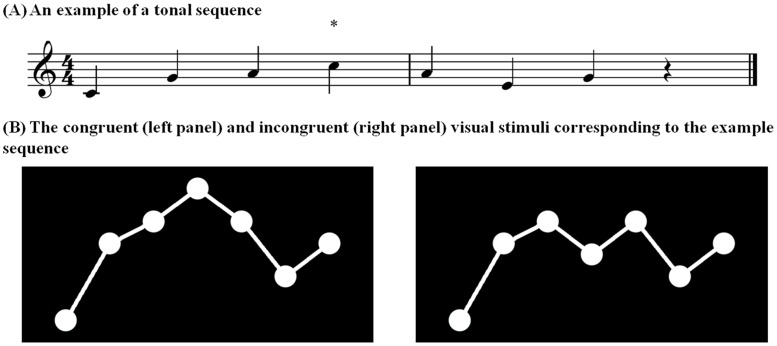
Illustration of the (A) auditory and (B) visual stimuli.* indicates the note that is either congruent (left panel) or incongruent (right panel) with the visual representation. In the incongruent condition, the change in the vertical position of dots is inconsistent with the change in direction of pitches in the accompanying melody.